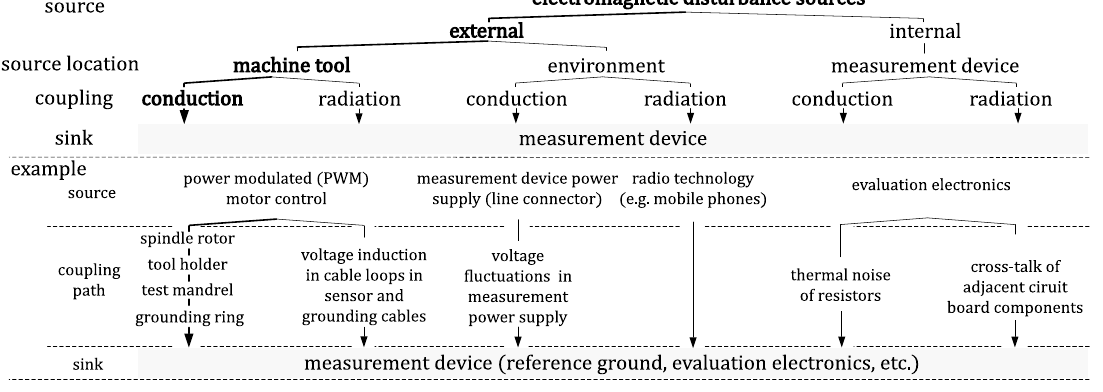
Figure 2. Categorization of electromagnetic interference mechanisms for capacitive displacement measurements in machine tool environments.